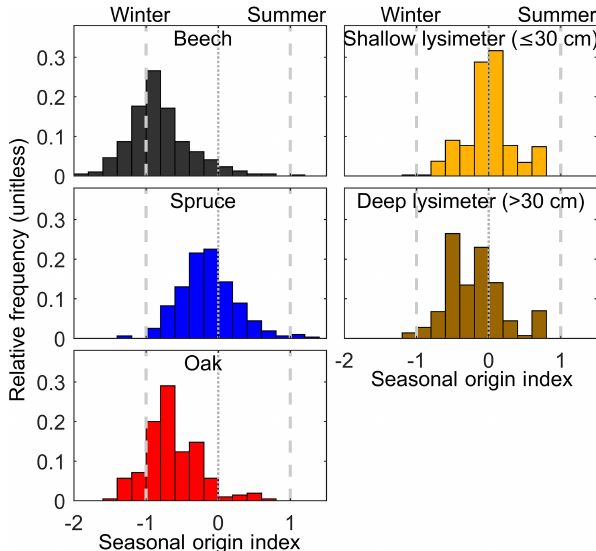
Figure 4. Field-measured fine root depths (a) versus site mean annual precipitation amount and (b) by species for single-species plots. Depth to root-mass center is the mean rooting depth weighted by density of roots per horizon. (a) Its variations were not lin- early related to mean annual precipitation ( R 2 < 0 . 01, p = 0 . 40). (b) The box plots show means (black line) ± 1 standard error (medium gray), and ± 1 standard deviation (light gray), of maximum (c) and mean (e) root depths, for the stands that only contained one of the study species; the data suggest that the three species have similar av- erage rooting depths across the sampled sites. See Fig. S2 for more detailed figures on soil and root depths. These metrics refer to fine roots (see